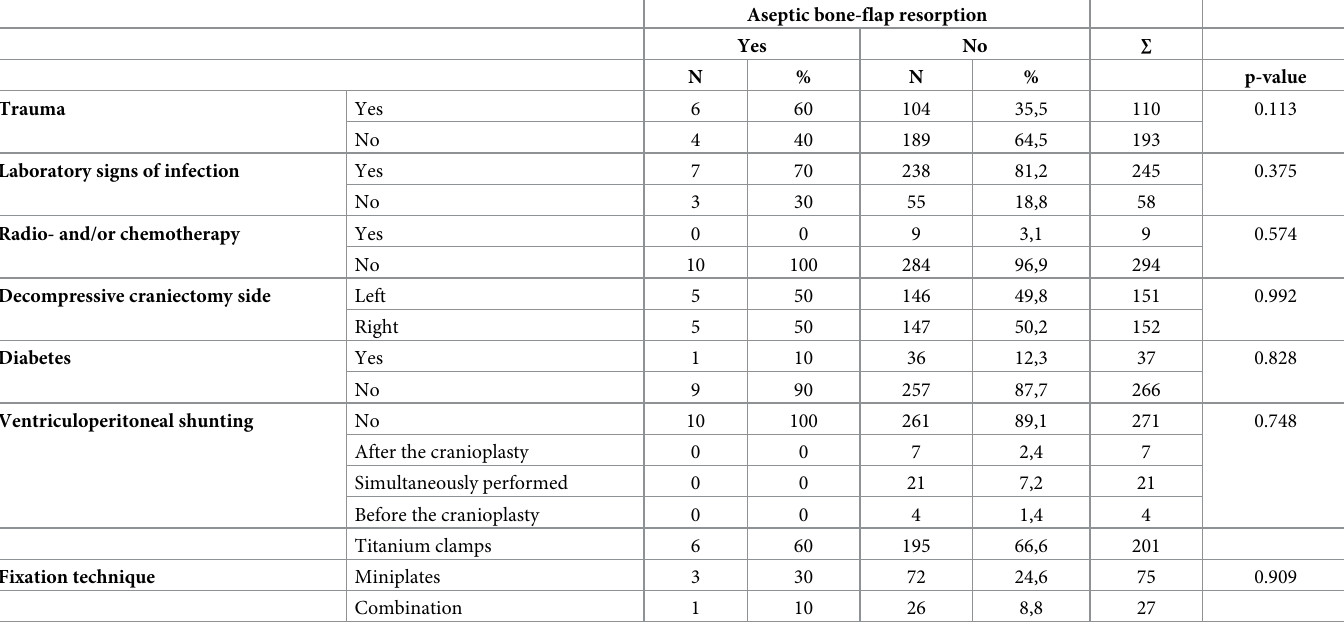
Table 2. Descriptive statistics and results of unadjusted tests for ABFR for categorical